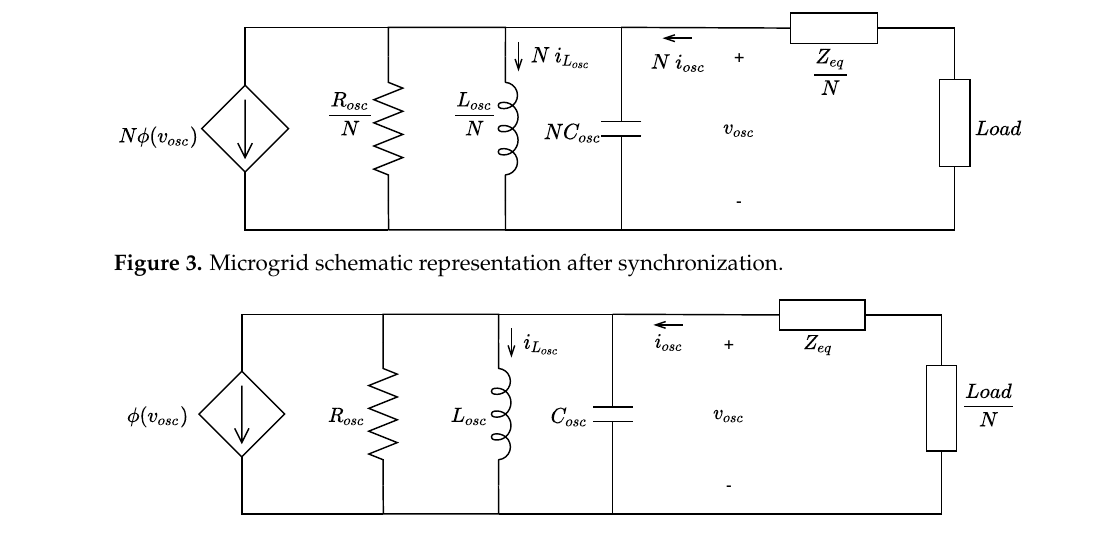
Figure 4. Operating condition of one inverter after